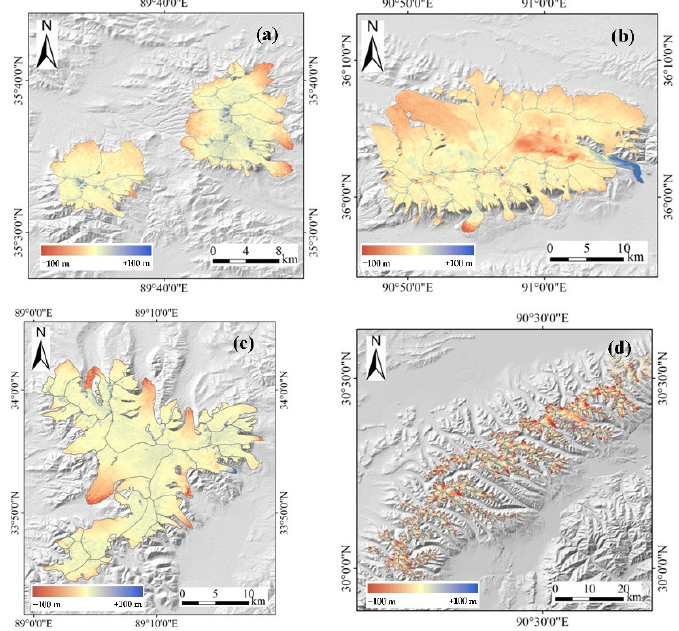
Figure 3. The observed maps derived by subtracting the SRTM-C DEM from the TanDEM-X DEMs over the study sites of Jinyanggangri Mount ( a ), Bukadaban peak ( b ), Puruogangri ice field ( c ) and Nainqentanglha Mts. ( d ).